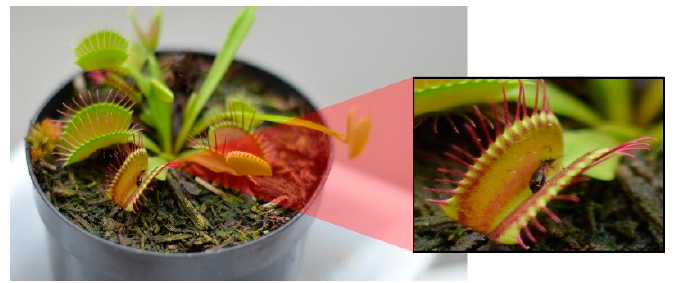
Figure 6. Venus flytrap ( Dionaea muscipula ) with its specialized cilia. Photo by Gabriel on